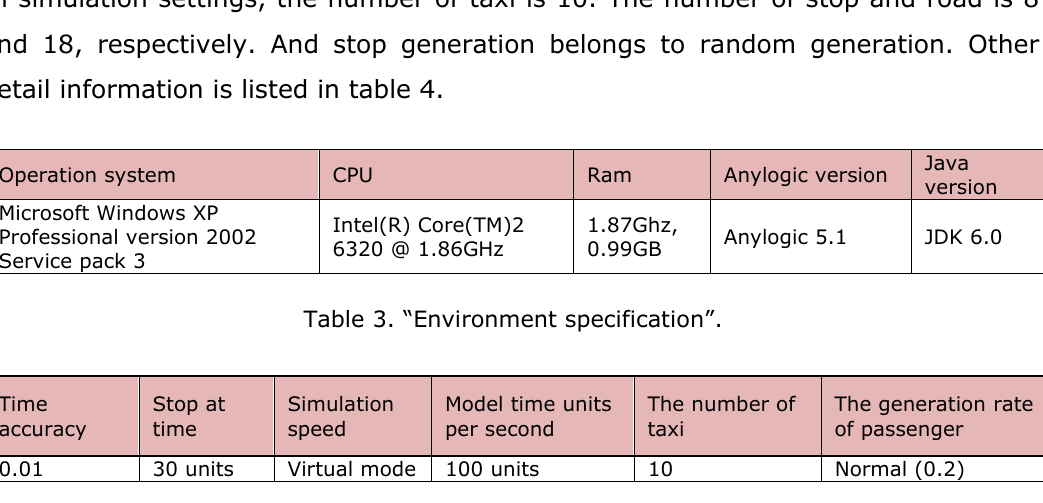
Table 4. “Simulation settings in Anylogic 5.1